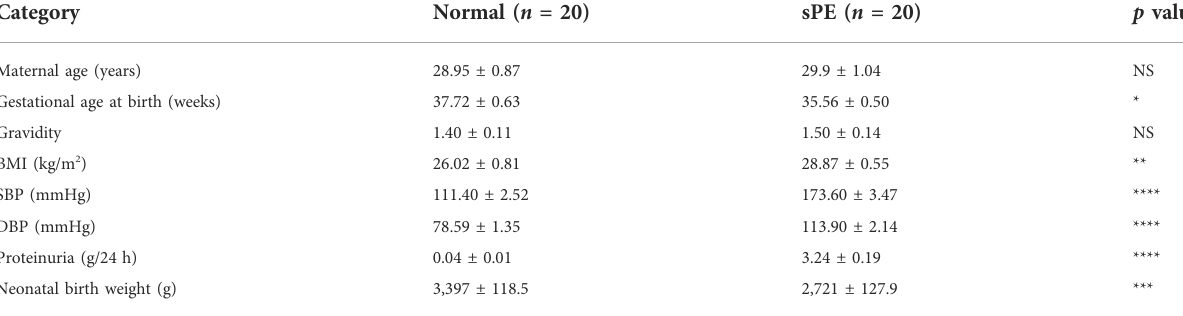
TABLE 1 Clinical features of patients in the normal and sPE groups.